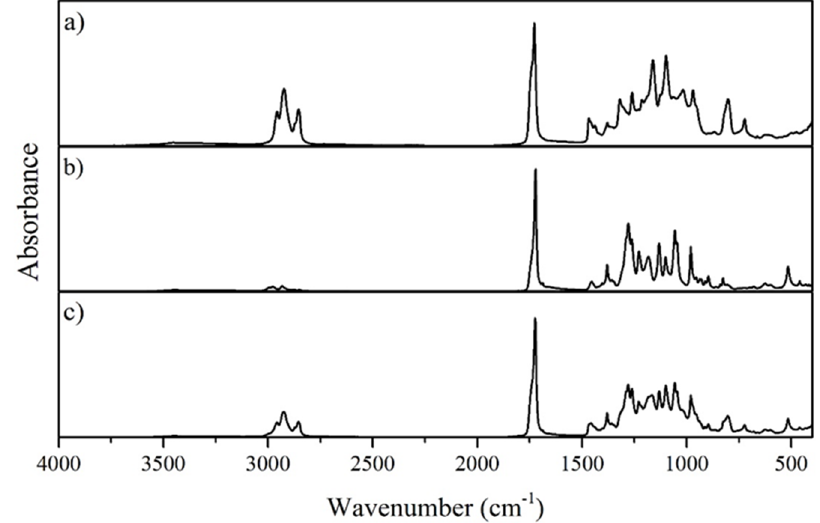
Figure 2. FTIR-ATR spectra of the mcl-PHA produced by P. citronellolis ( a ), the P(3HB) produced by C. necator ( b ), and the P(3HB)/mcl-PHA produced by the co-culture ( c ) from apple pulp waste.